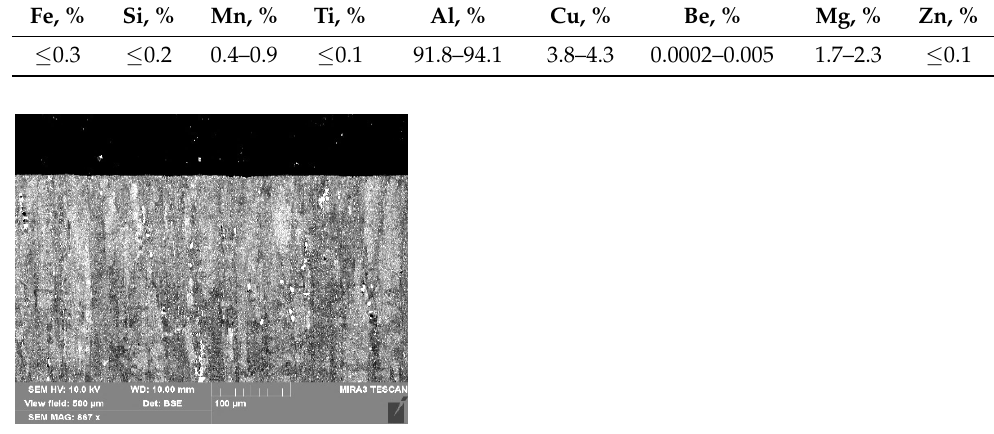
Figure 4. Microstructure of uncoated aluminum sample.